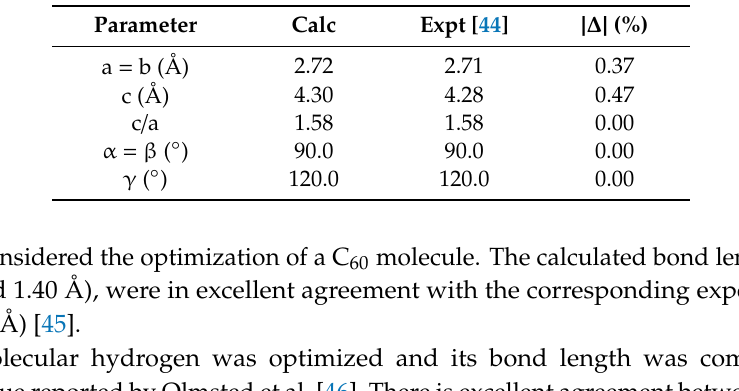
Table 1. Calculated and experimental lattice parameters of hexagonal ( P 63 /mmc ) Ru.